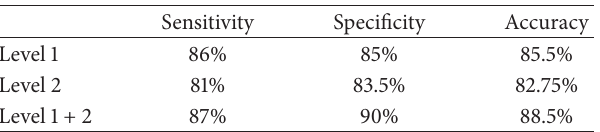
Table 8: Results obtained using DWT + ULBP [7] in RGB color space.